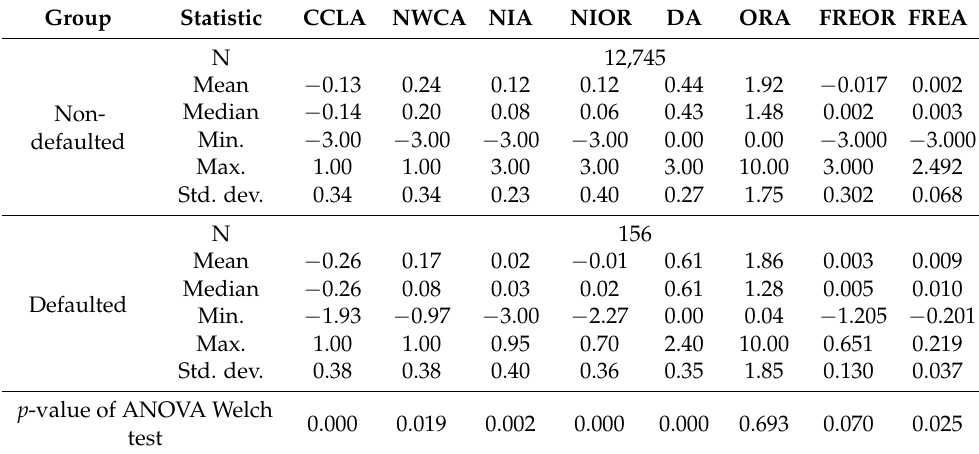
Table 5. Descriptive statistics of financial variables.